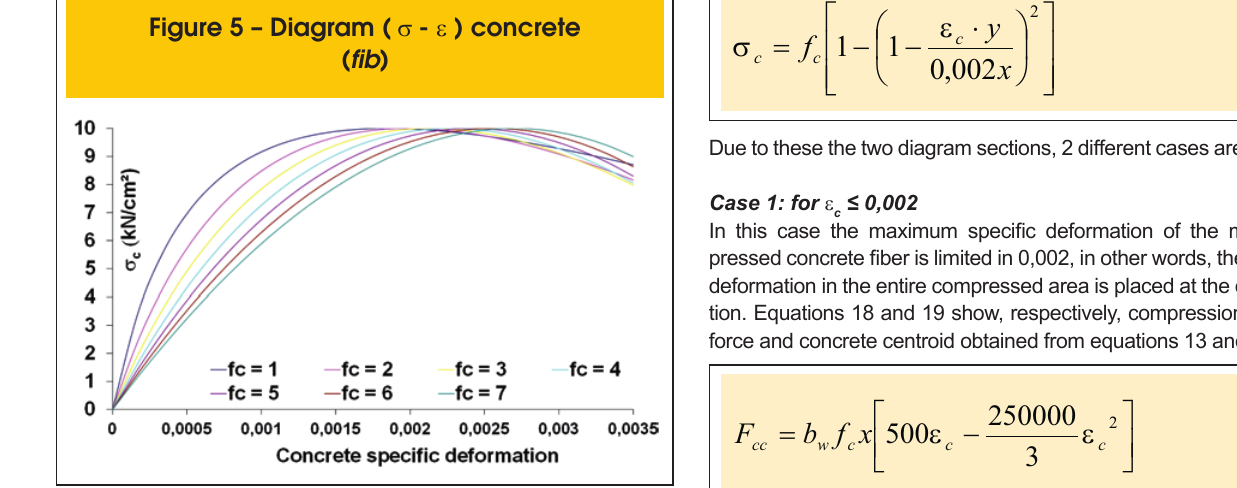
Figure 5 – Diagram (  s  - e ) concrete ( fib